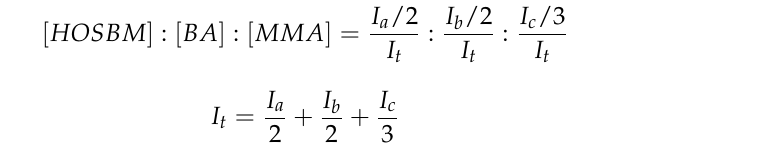
Figure 1. 1 H NMR spectra of terpolymers HOSBM-BA-MMA. The resulting molar composition of terpolymers, based on integrals of characteristic peaks ( I a , I b , I c ) (Figure 1), was calculated using Equation (1). The amount of BA/MMA was calculated by subtracting the integral value of the signals at HOSBM homopolymer spectrum at ~4.15 and 3.7 ppm (2.2 and 2.3, respectively) from the determined value. The 1 H NMR spectrum for HOSBM homopolymer is presented in the supporting information (Figure S2). The conversion calculations from mole fraction to weight fractions have been performed for all compositions presented in the Table 1. Terpolymers HOSBM-BA-MMA were obtained with high conversion (>90%), and their compositions based on 1 H NMR measurements were very similar to the theoretical one (Table 1).